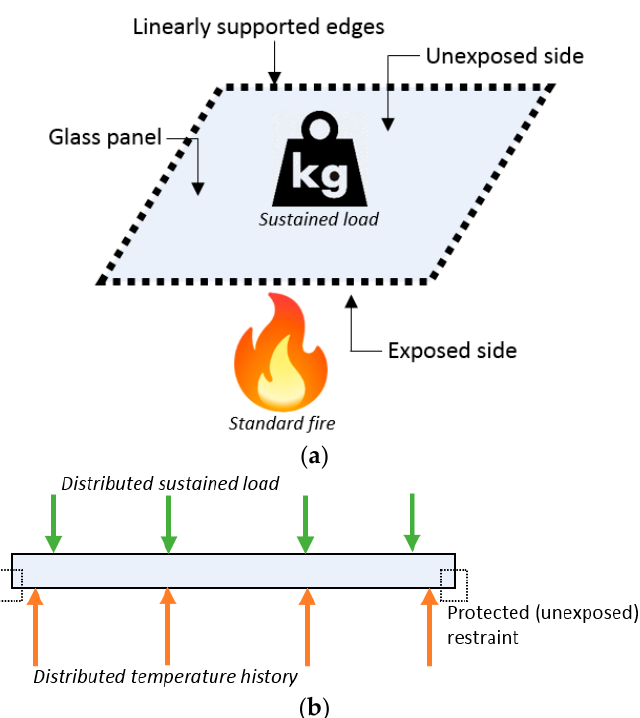
Figure 2. Reference system: ( a ) schematic setup and ( b ) cross ‐ section.